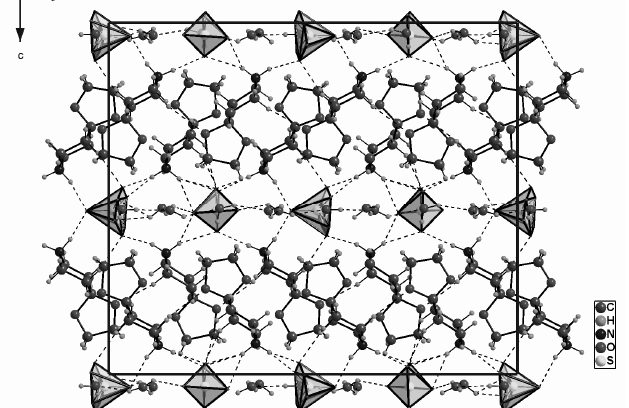
Figure 1. ORTEP Drawing showing the asymmetric unit of (C with the atom-labelling scheme. Displacement ellipsoids are drawn at the 30% probability level. H atoms are represented by spheres of arbitrary